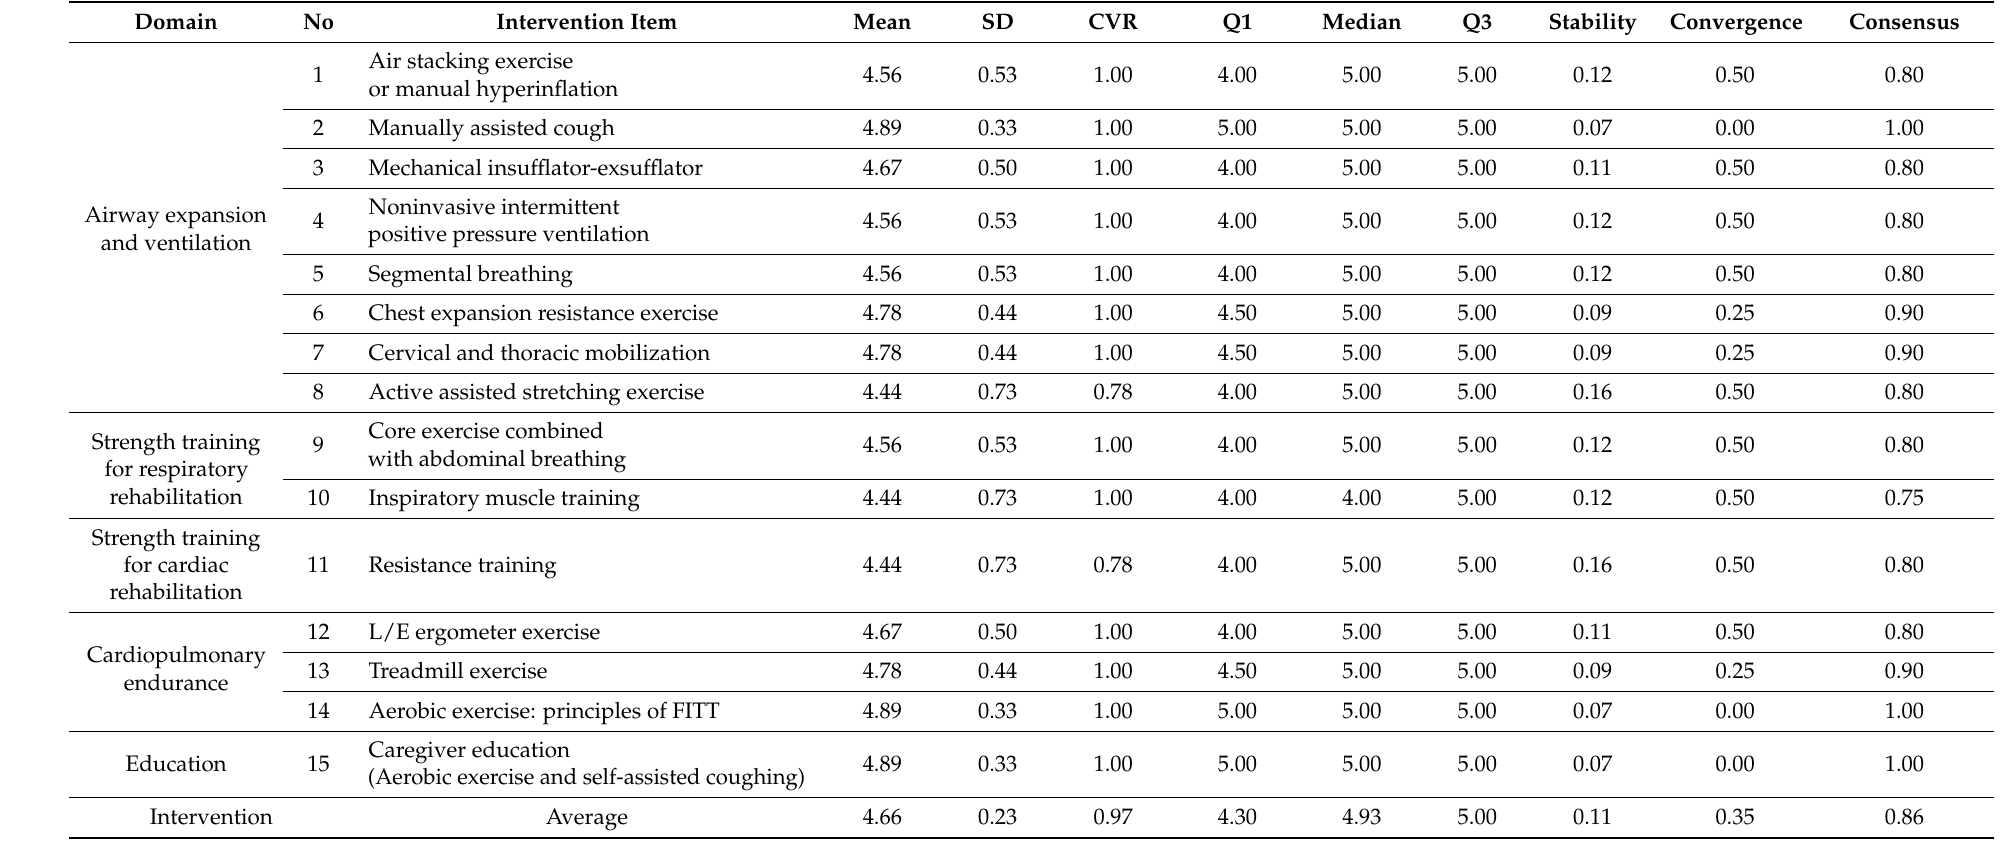
Table 4. Results of items after the second modified Delphi